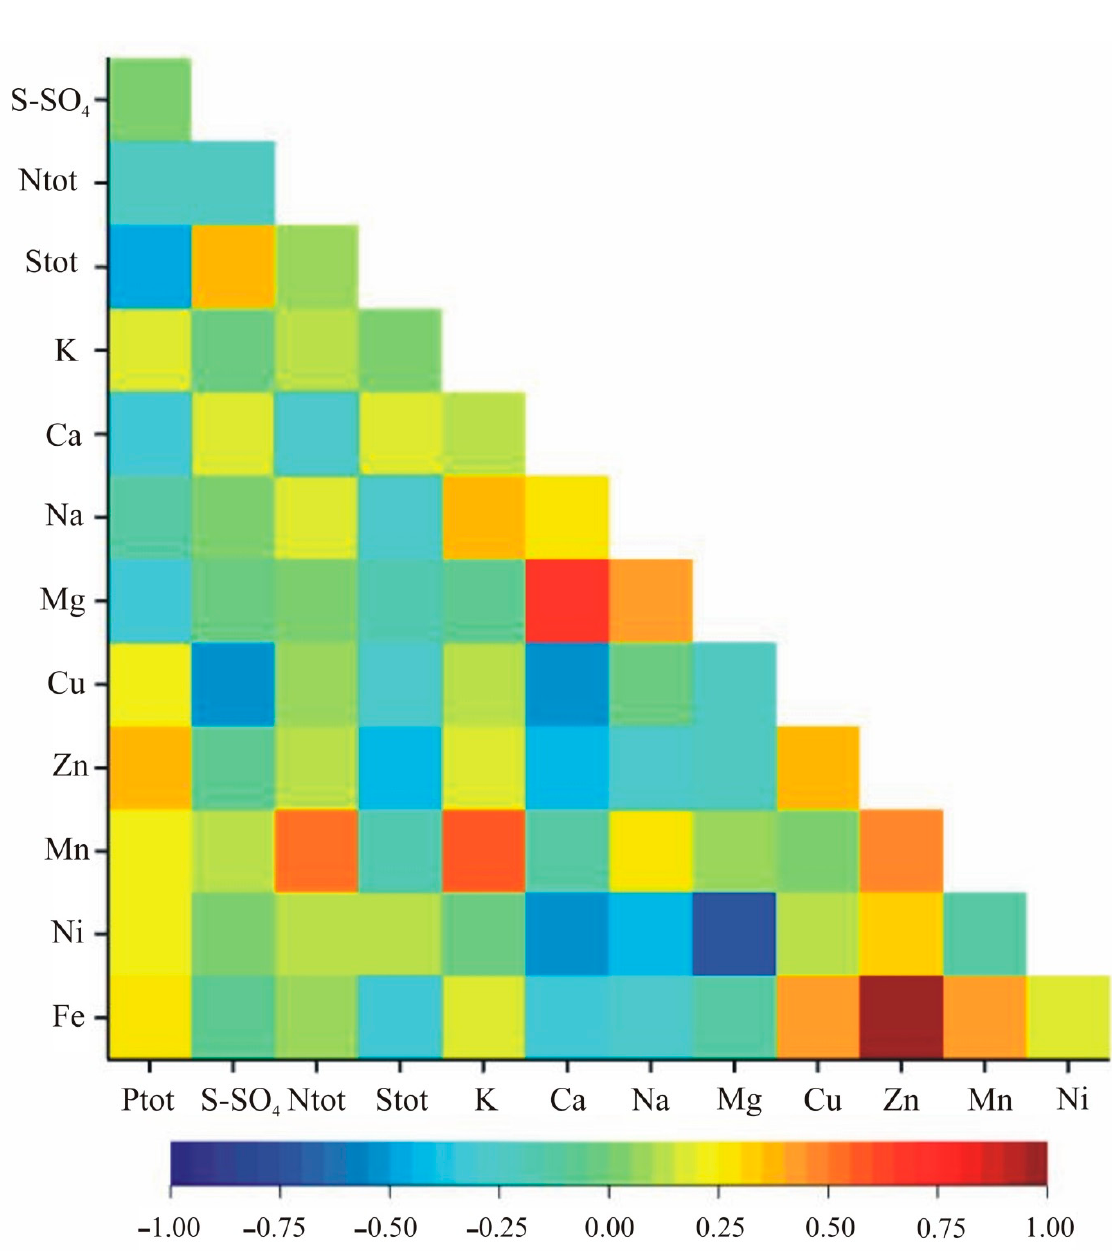
Figure 3. Heatmap for linear Pearson’ correlation coefficients between observed nutrients in the vegetative stage ( r cr = 0.36).